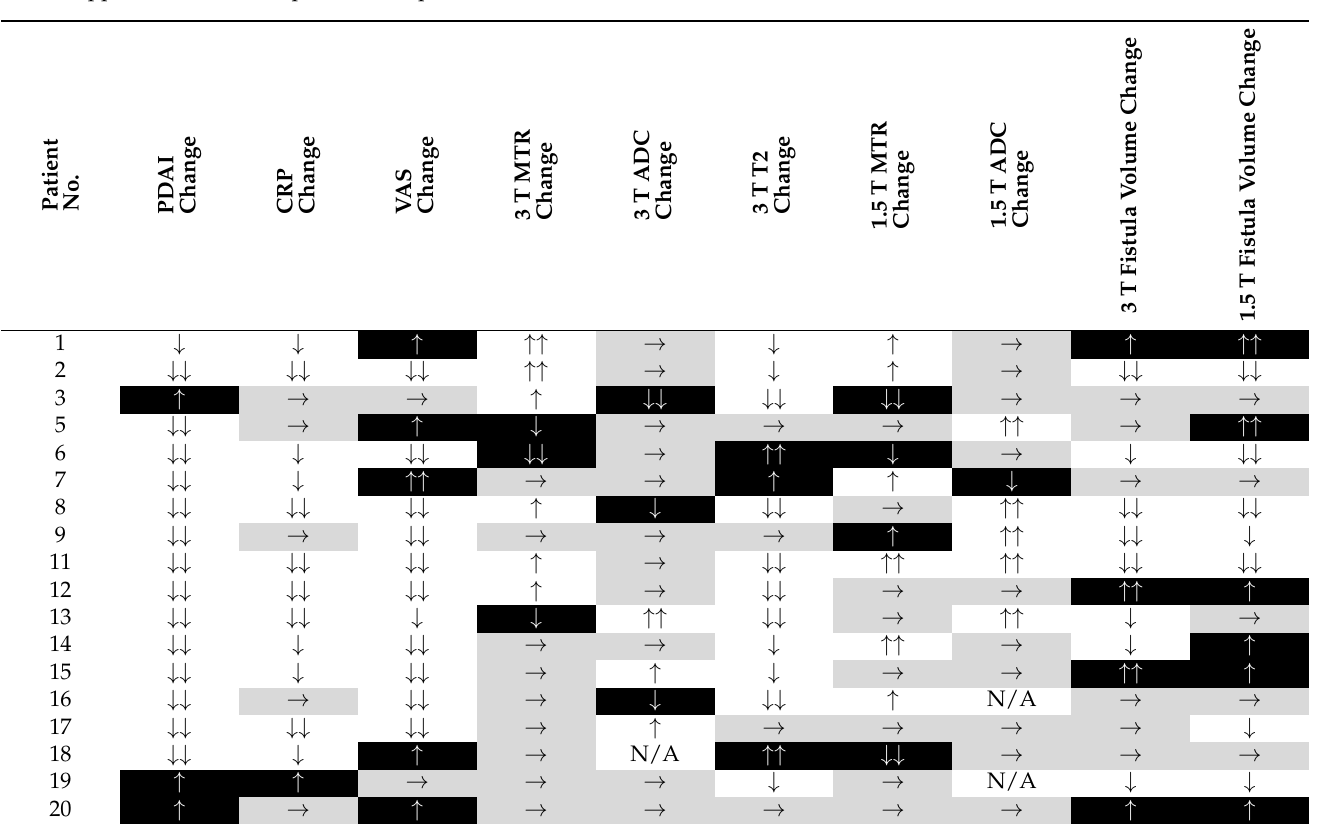
Table 2. Graphical representation of each individual patient data changes for all clinical and MRI parameters. Shading: decrease/increase is expected as a response to treatment—white. No change in parameter/score—grey. Decrease/increase is opposite to what is expected as response to